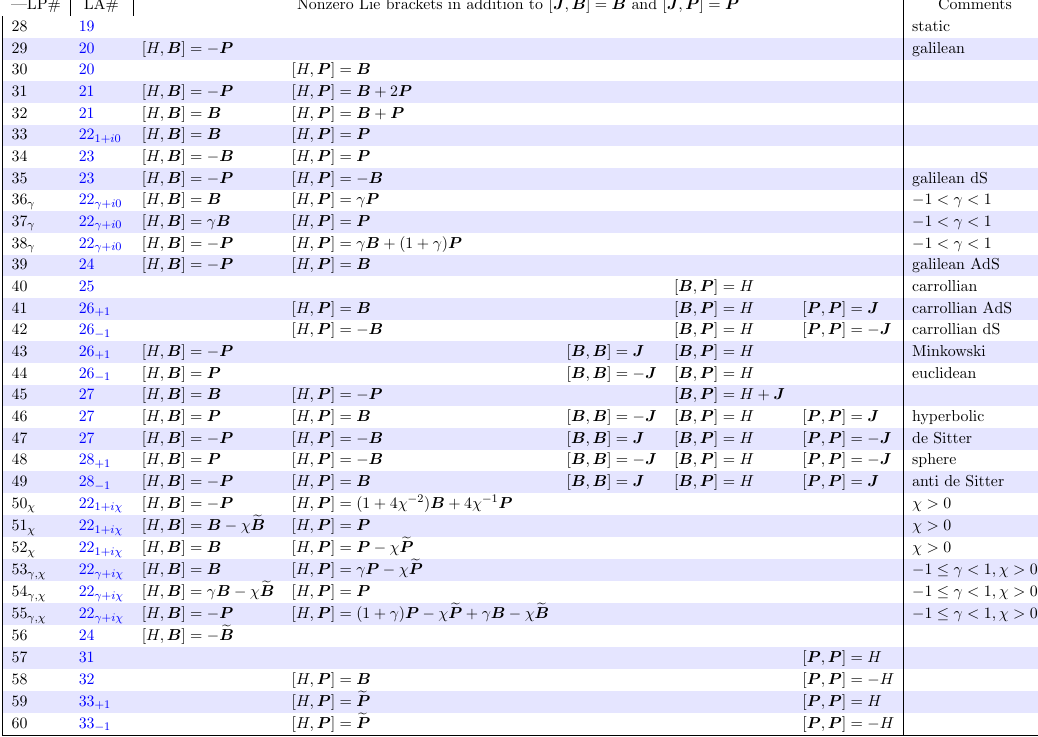
Table 9 . Lie pairs for kinematical Lie algebras ( D = 2, real form).